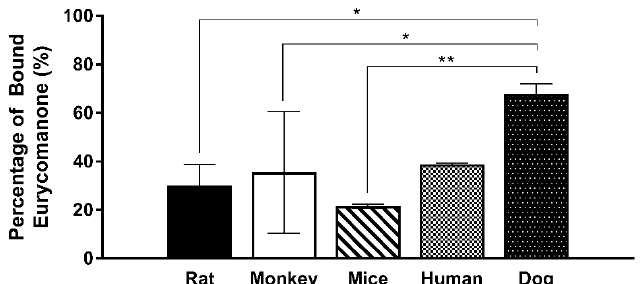
Figure 8. Eurycomanone plasma protein binding in rat, monkey, mice, human, and dog plasma. The values were plotted based on the mean ± standard deviation. ** and * denote significant difference when compared to across species ( p ≤ 0.01) and ( p ≤ 0.05) respectively. No significant difference was found between the rest of the species tested ( p ≥ 0.05) (not indicated on graph).